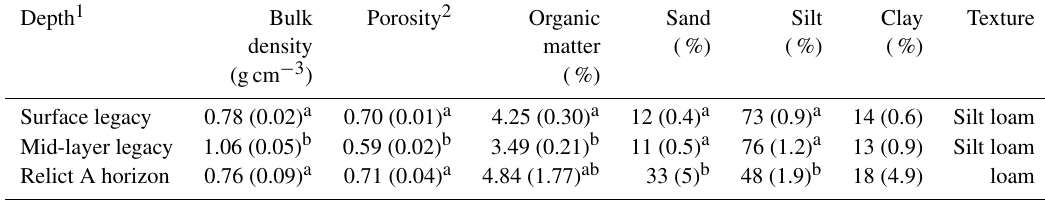
Table 1. Bulk density, porosity, texture, and particle size distribution classes (sand, silt, and clay) expressed as averages across soil depths (surface legacy sediment, mid-layer legacy sediment, and relict A horizon soil). Values are means ( n = 8 for bulk density and porosity, and n = 5 for organic matter content and particle size classes) and 1 standard error in parentheses. Bulk density and organic matter content values reproduced from Weitzman et al. (2014).